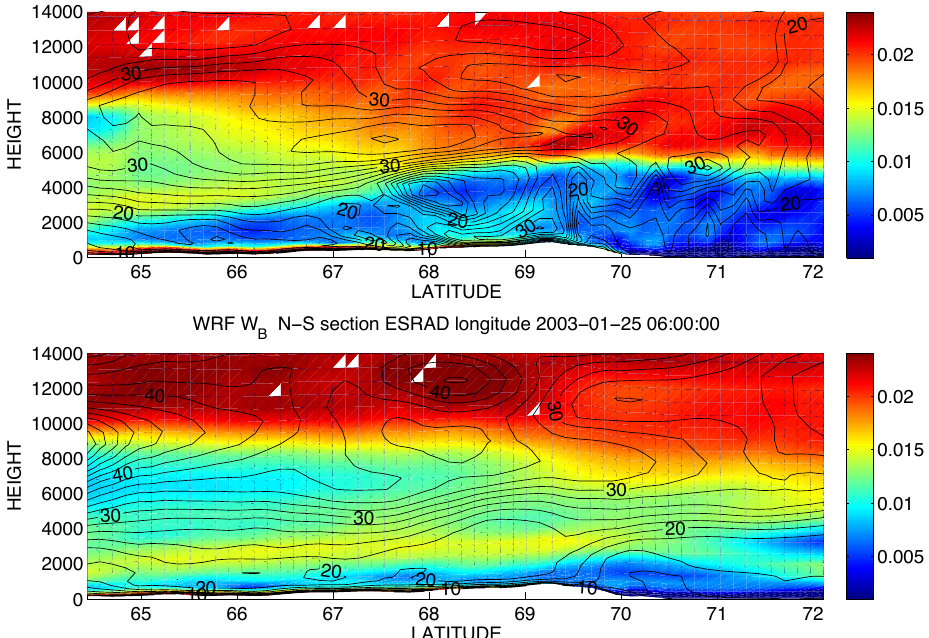
Fig. 11. Latitude-height cross sections of buoyancy frequency (colour scale, units s − 1 ) and wind speed (contours, unitsm/s) from an extended outermost model domain (15km horizontal grid). The cross sections are at the ESRAD